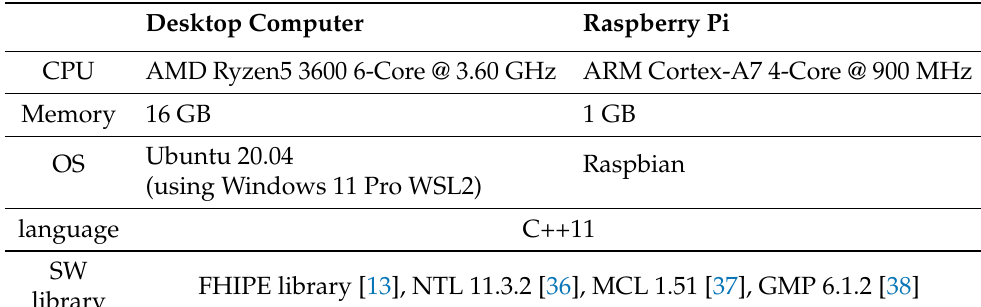
Table 1. Experimental setup for performance analysis.